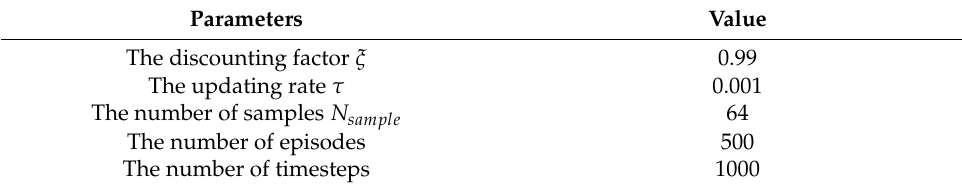
Table 2. Simulation parameters of